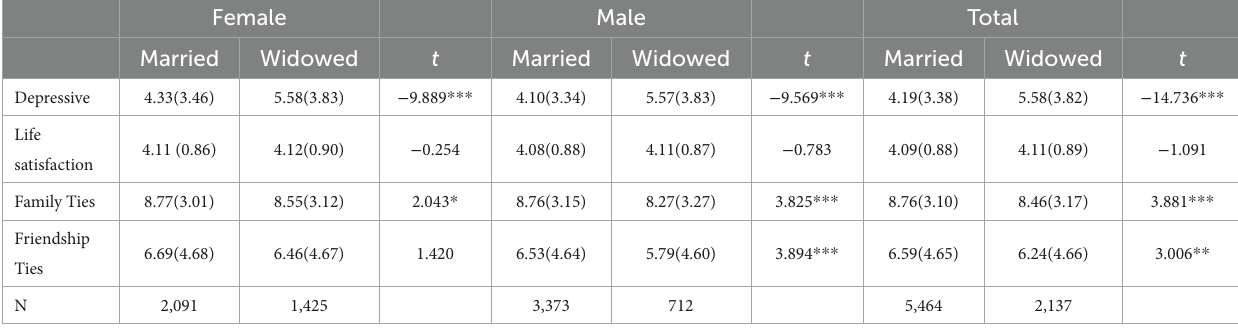
TABLE 2 Lubben Social Networks Scale (Family and Friendship Ties Subscales) and depressive symptoms by marriage in male and female samples.